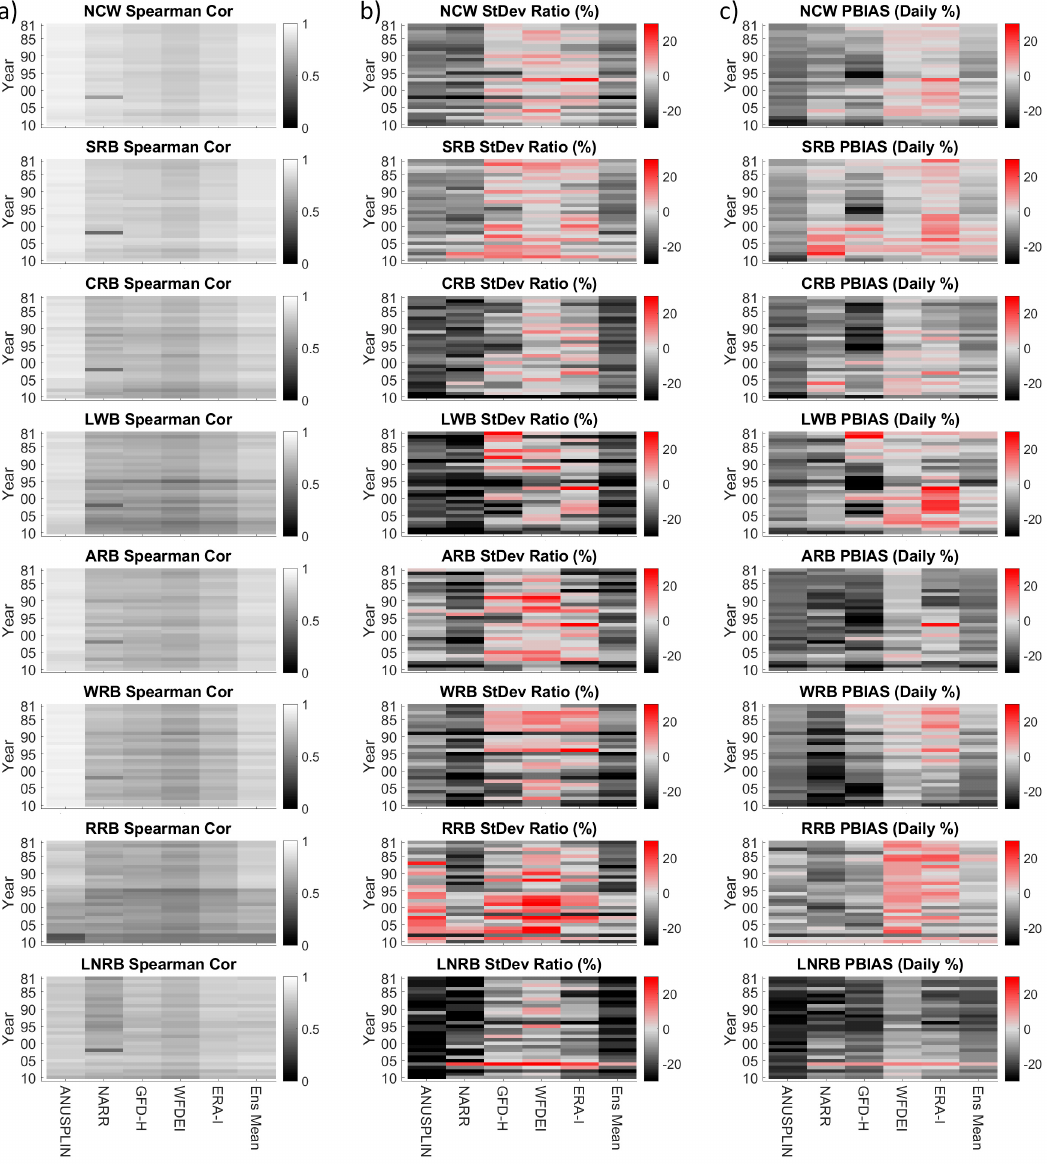
Figure 3. Daily precipitation spatially aggregated annual continuous statistics with reference to the AHCCD observed data set in each sub-basin (1981–2010). ( a ) Daily Spearman correlation, ( b ) daily ratio of standard deviations, and ( c ) daily PBIAS.